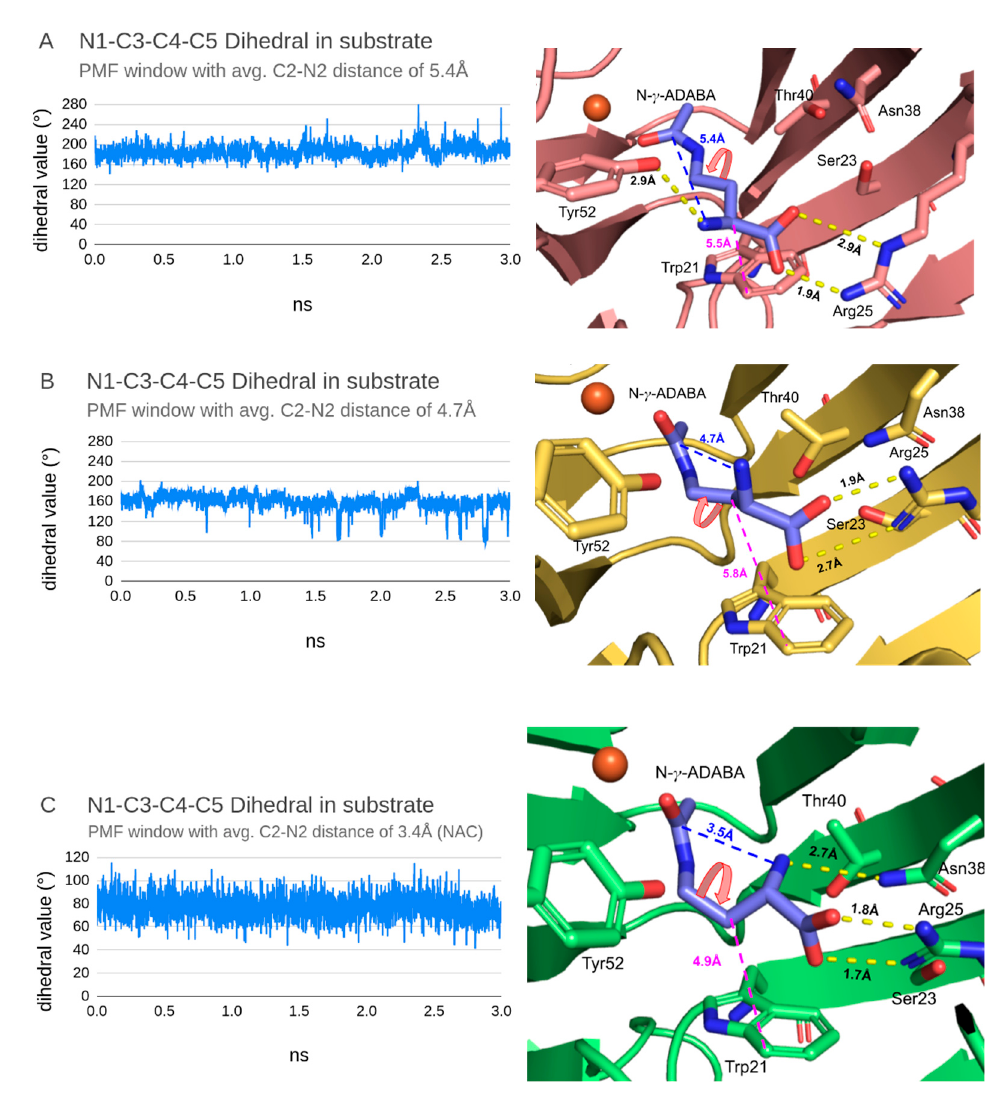
Figure 6. Time profiles of the N1-C3-C4-C5 dihedral angle values ( left column ) and representative correlated active site geometries extracted from three MD windows ( right column ). The dihedral angles are indicated by red, bent arrows on the graphics. Yellow dashed lines show hydrogen bonds present in given geometry of an active site, blue dotted line indicates the C2-N2 distance in the substrate and magenta dotted line shows the distance between the substrate (C4 carbon atom) and the indole ring of Trp21 (CZ2 carbon atom). The three MD windows approximate the two minima and one maximum on the free energy plot (see Figure 5). Top ( A ): the minimum with 5.32 Å C2-N2 distance, middle ( B ): maximum with 4.7 Å C2-N2 distance, bottom ( C ): NAC with 3.5 Å C2-N2 distance.